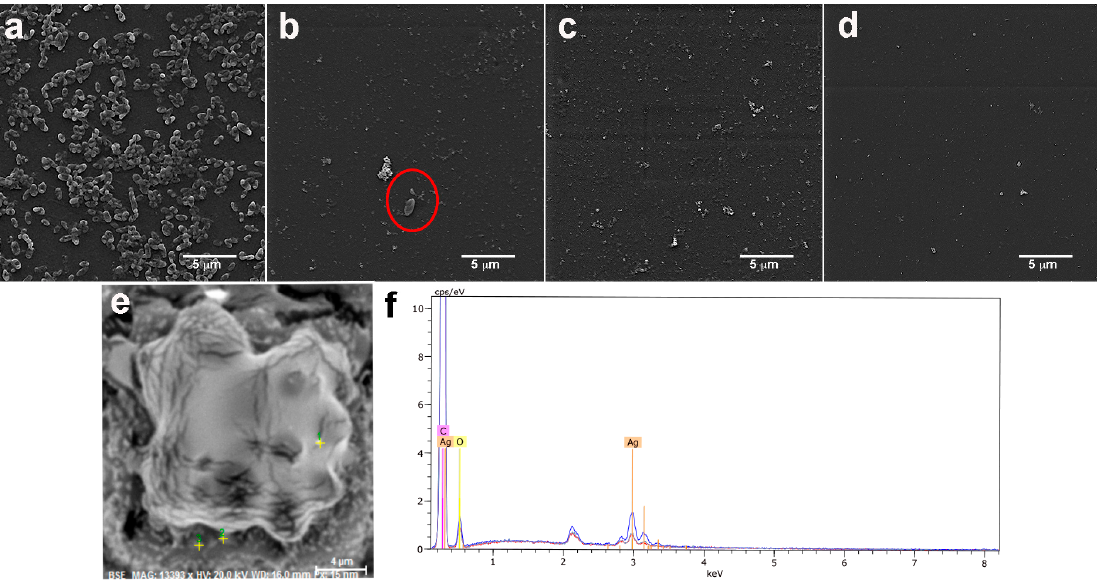
Figure 9. Pseudomonas aeruginosa incubated for 24 h on ( a ) AA2024 + TE + PMMA, ( b ) AA2024 + TE + PMMA-Ag 0.01 wt%, ( c ) AA2024 + TE + PMMA-Ag 0.1 wt%, ( d ) AA2024 + TE + PMMA-Ag 1 wt%, ( e ) AA2024 + TE + PMMA-Ag 1 wt% analyzed by EDS (1, 2, 3 correspond to each measurement point),